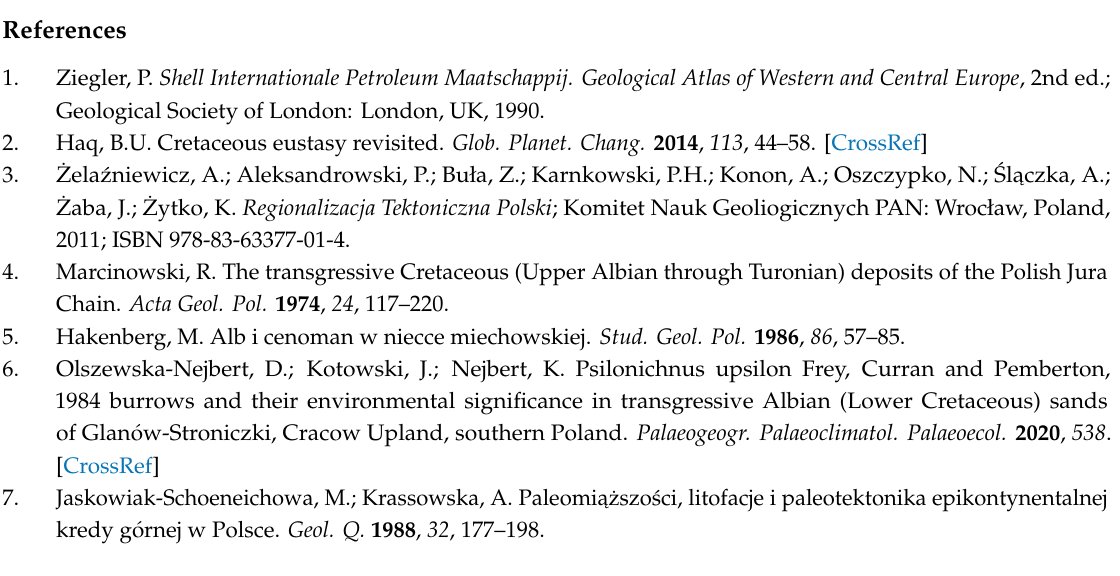
Table S1: Chemical composition of tourmaline from the Albian sands in the Miech ó w